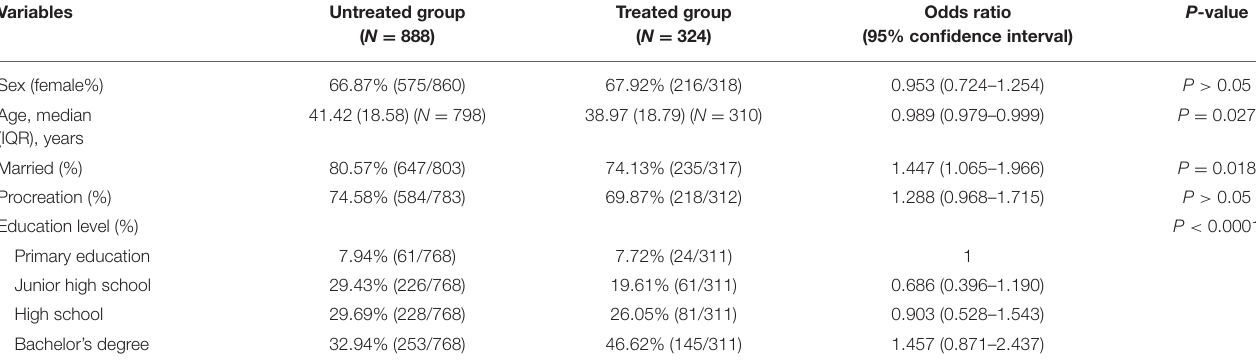
TABLE 1 | Patient Characteristics in the treated group and untreated